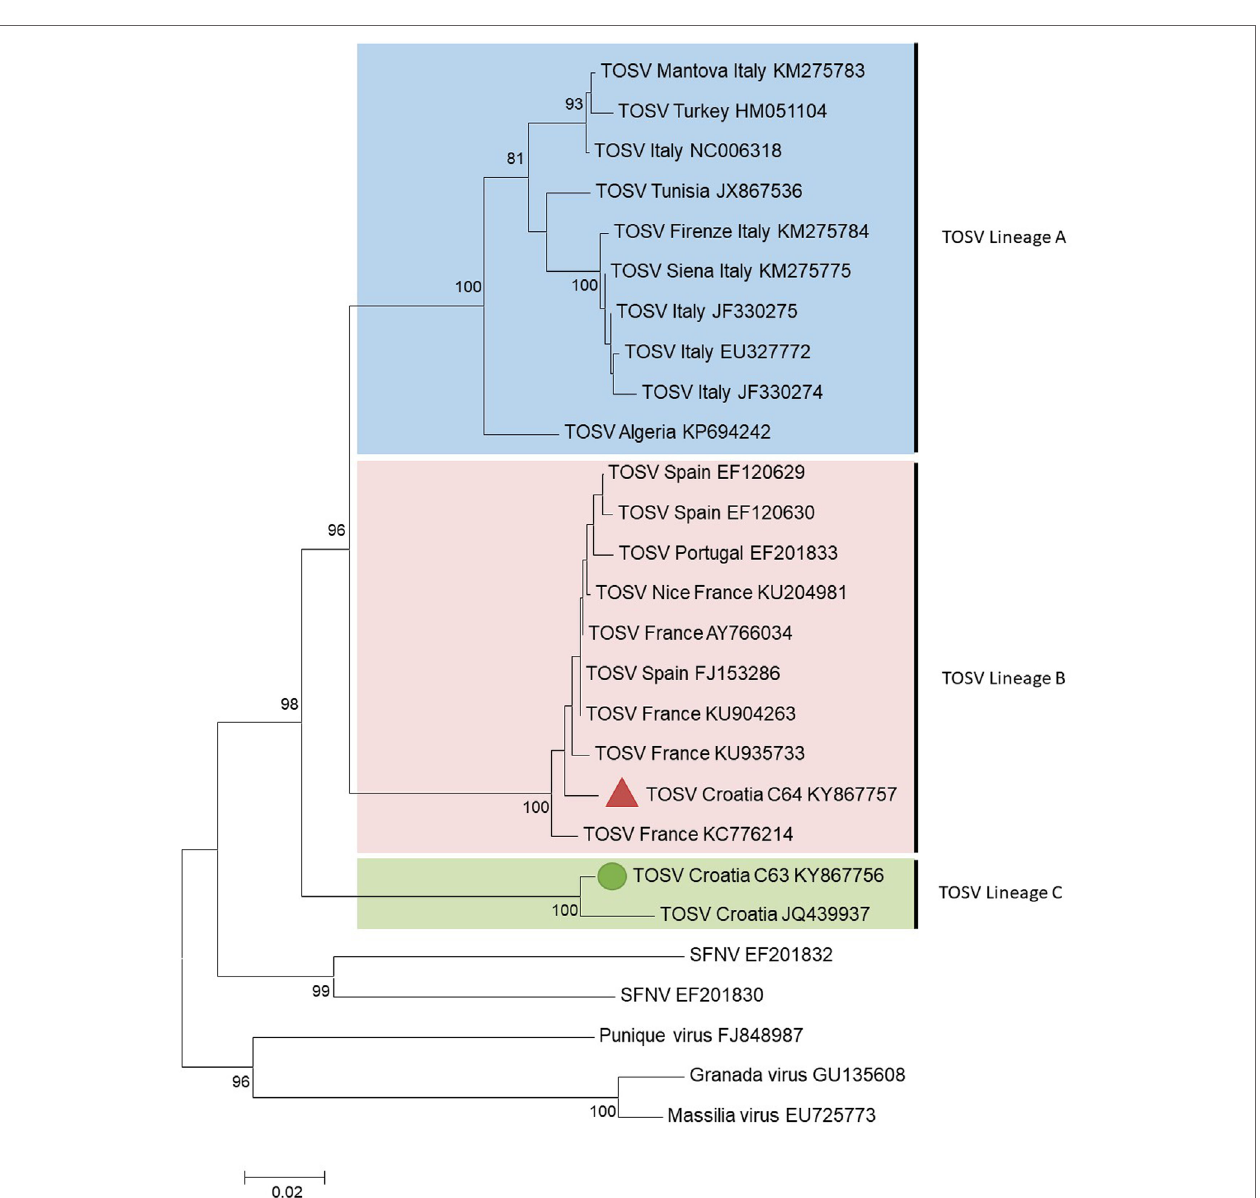
FIgURe 1 | Phylogenetic analysis of Toscana virus (TOSV) based on a 576-nt long sequences between positions 88 and 663 (numbered after strain IssPhL3, Acc No X53794) located in the nucleoprotein gene. Distances and groupings between the N protein sequences were determined by the p-distance algorithm and the neighbor-joining method with the MEGA 6.06 software program (12). Bootstrap values are indicated and correspond to 1,000 pseudoreplications.